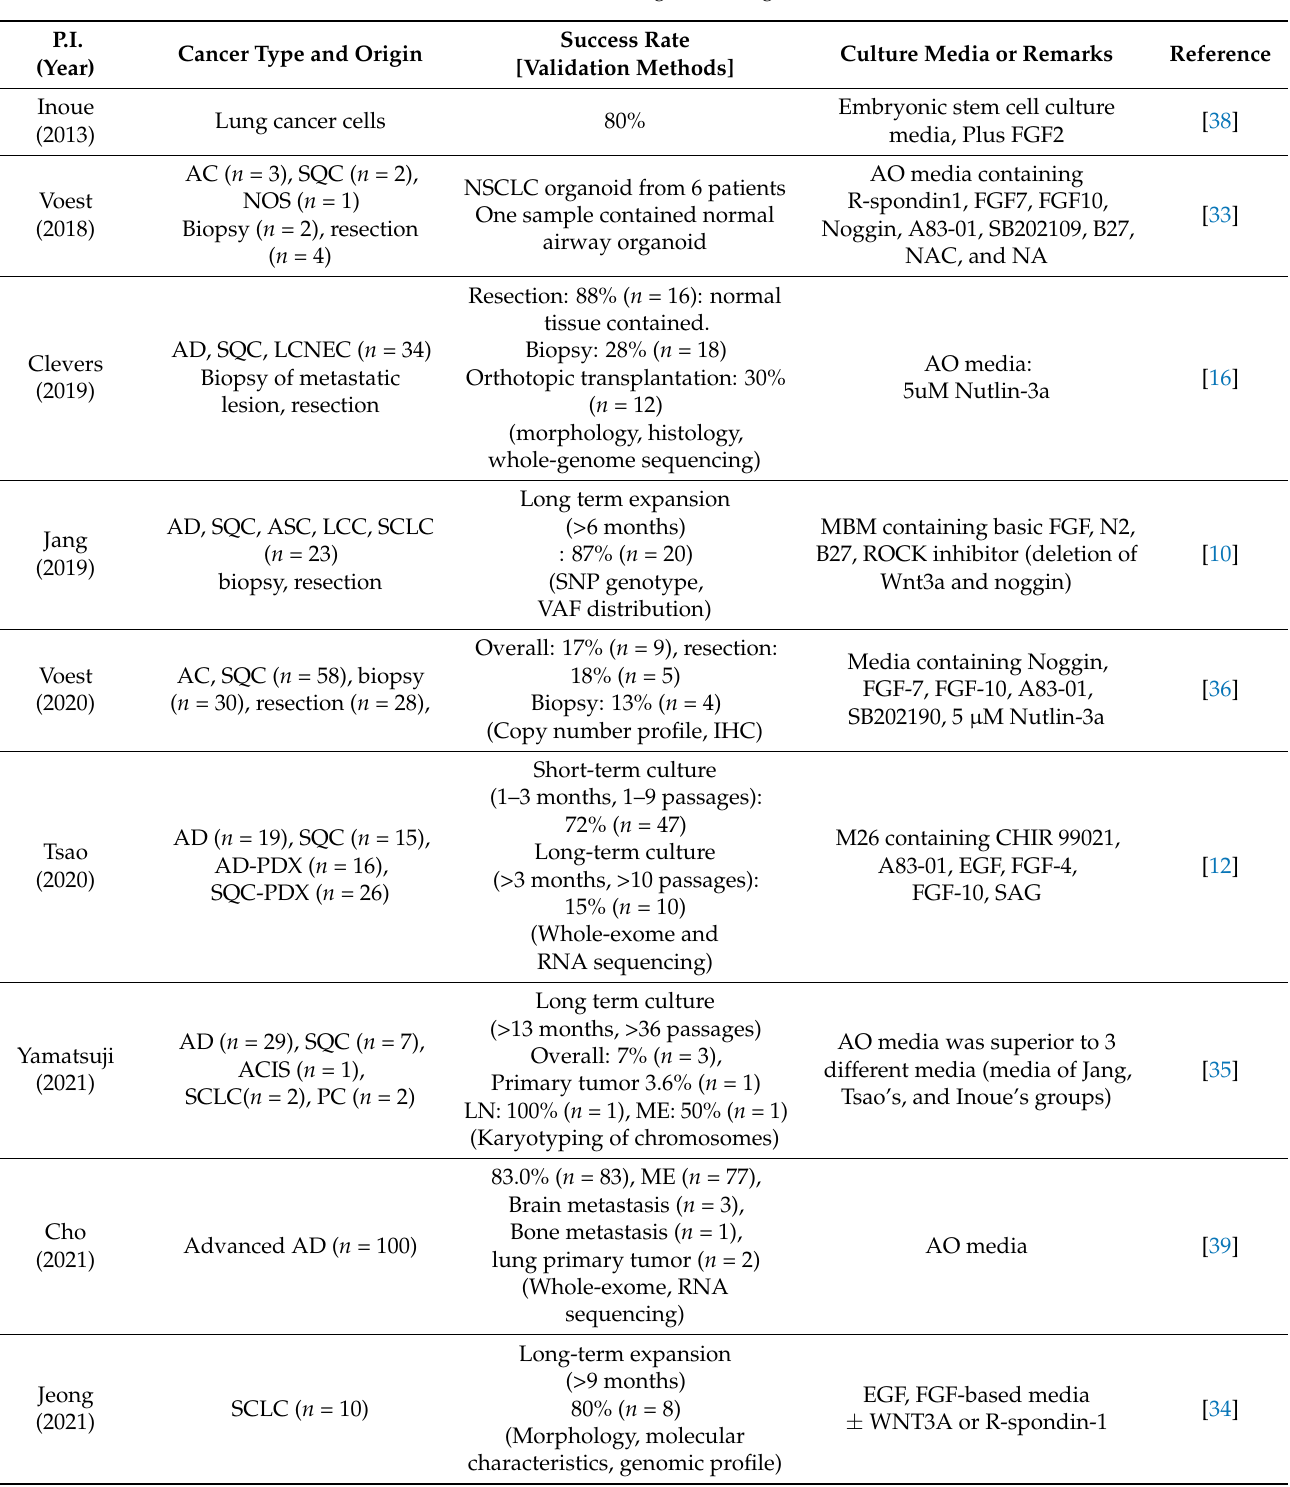
Table 2. Studies of lung cancer